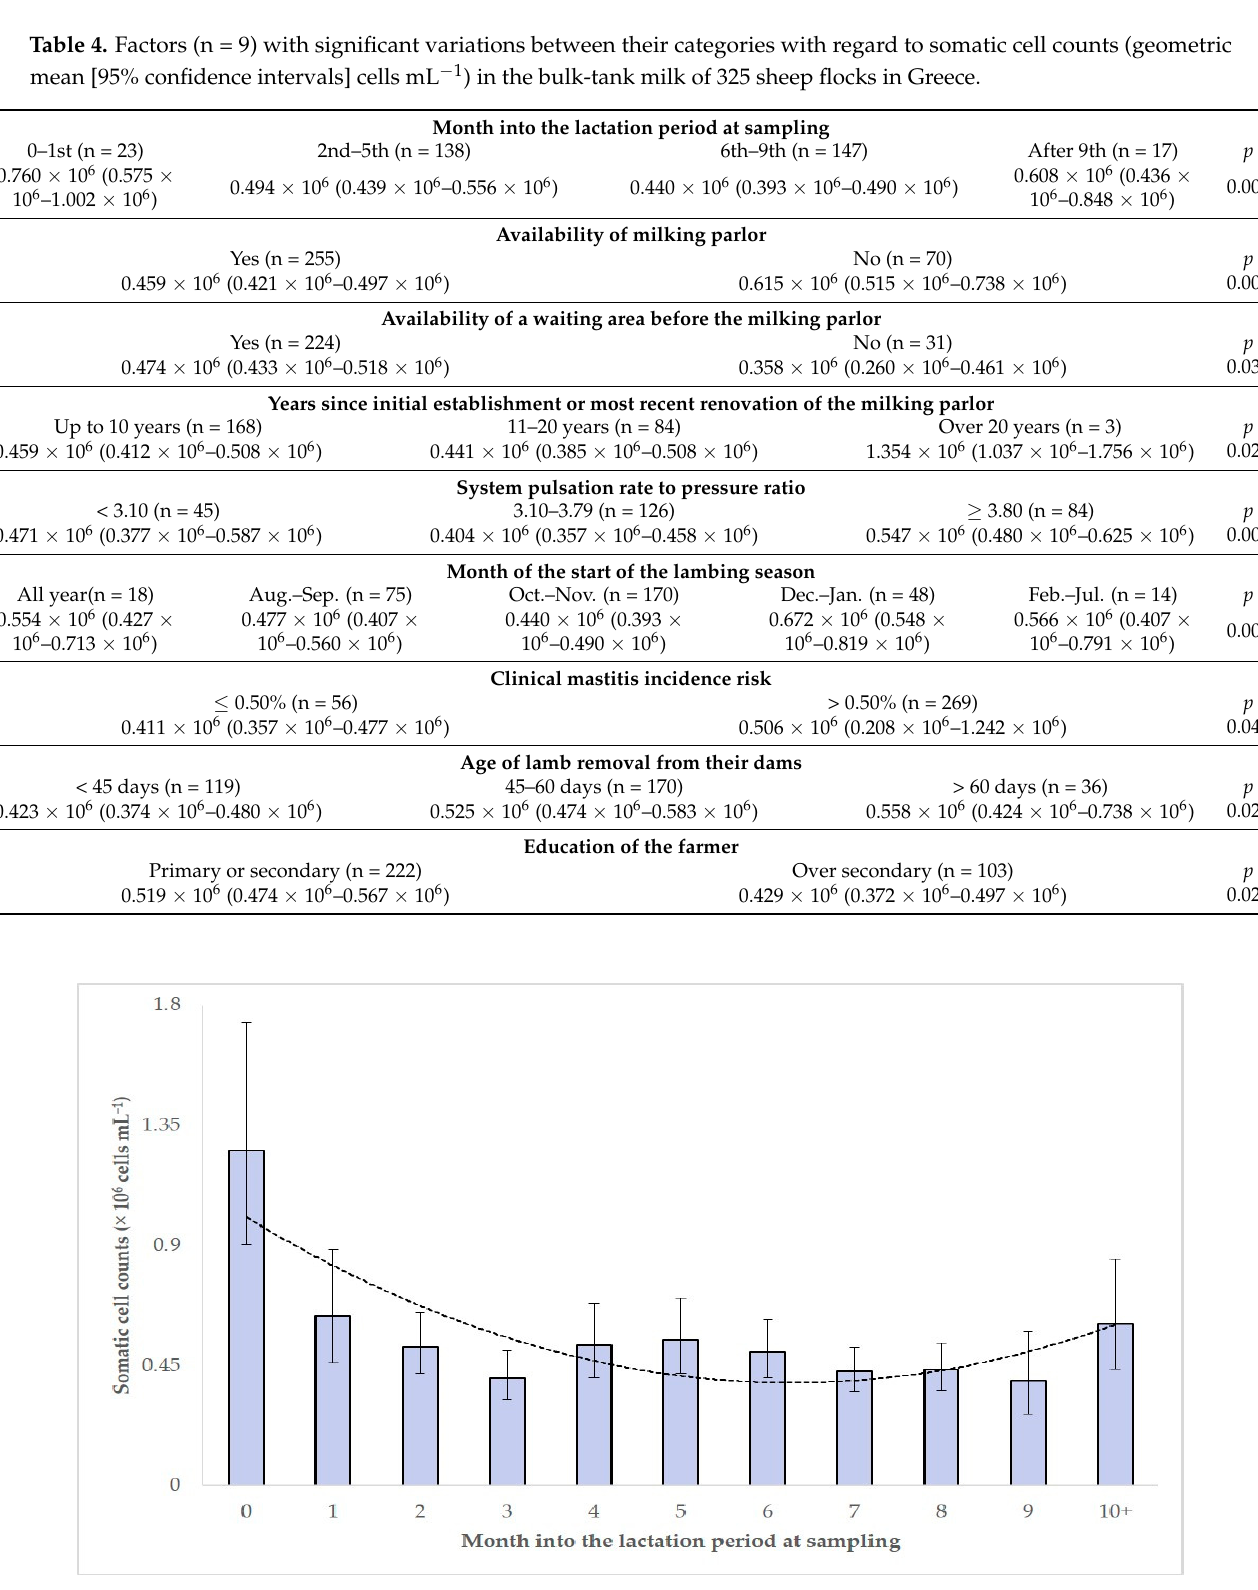
Figure 4. Geometric mean somatic cell counts in the bulk-tank milk of 325 sheep flocks in Greece, in accord with the month of the lactation period at which each flock was at the time of sampling (bars indicate 95% confidence intervals of the geometric mean, dotted line indicates tendency line).